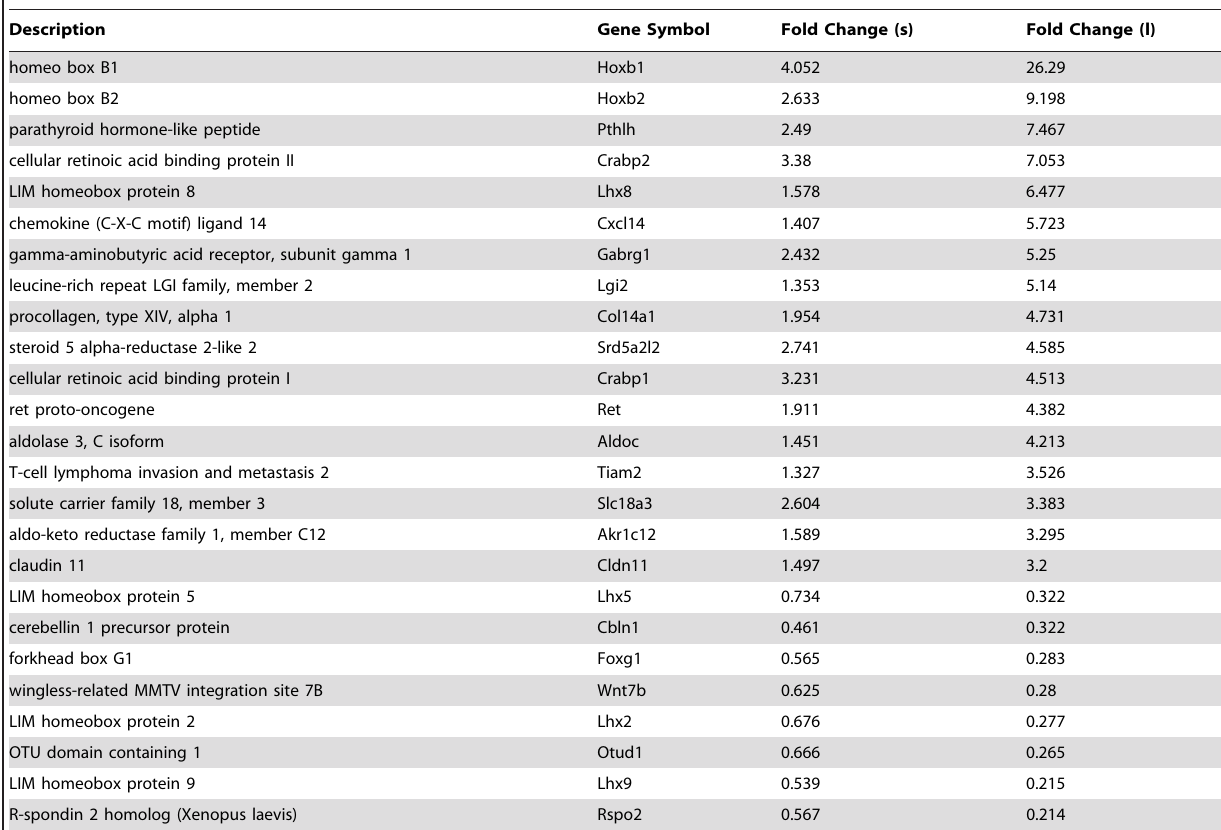
Table 2. Hoxb1 regulated